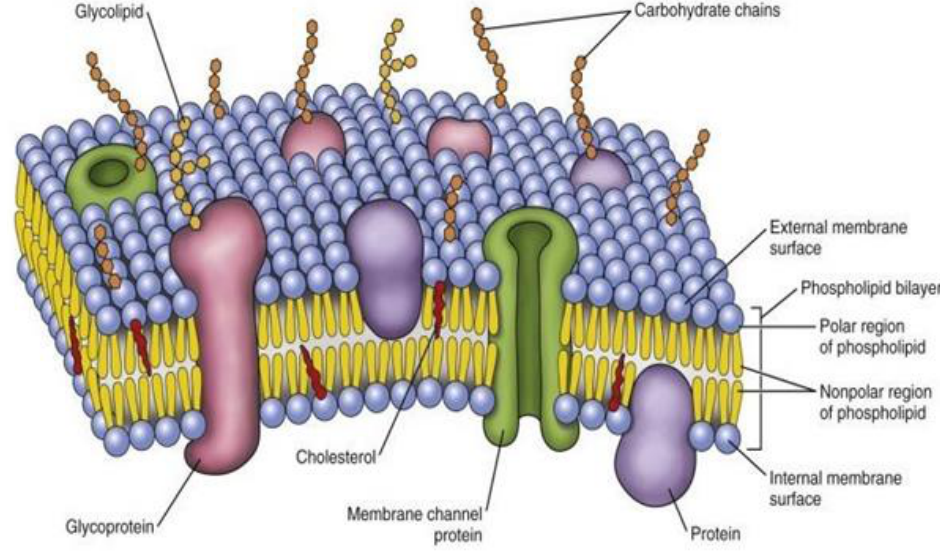
Figure 1. Components and layers of biological membrane.